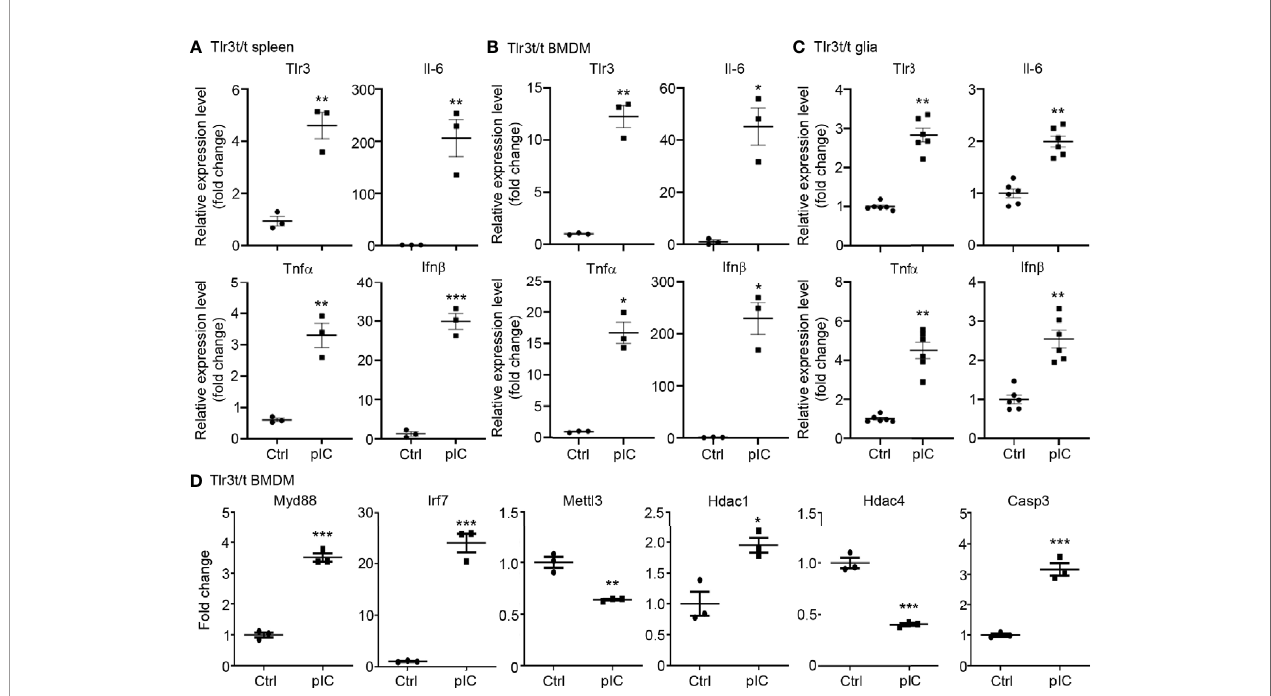
FIGURE 5 | Poly(I:C) stimulation altered the expression of Tlr3 and downstream genes in Tlr3 t/t spleen and cells. (A) Quantitative RT-PCR analysis of Tlr3 and the cytokines Il-6 , Tnf a and Ifn b in poly(I:C)-challenged Tlr3 t/t mouse spleen. Six hours after an intraperitoneal injection of 5 mg/kg poly(I:C), total RNA was extracted from spleens of Tlr3 t/t mice using TRIzol reagent. The expression levels of indicated cytokine genes were normalized against the internal control Hprt . (B – D) Primary cultures of BMDMs (B, D) and glia cells (C) from Tlr3 t/t mice were stimulated with 10 m g/ml poly(I:C) for 6 h. The relative RNA levels of indicated genes normalized against the internal control Hprt were analyzed by means of quantitative RT-PCR. Data are represented as mean ± SEM ( error bars ). Each dot indicates the result of (A) an individual animal or (B – D) an independent culture. *p > 0.05; **p > 0.01; ***p >